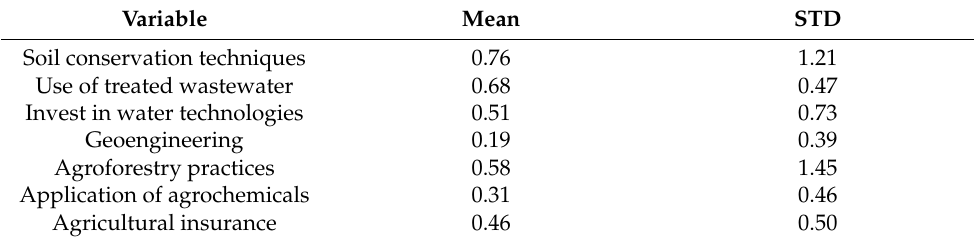
Figure 2. Main adaptation measures promoted by farmers. Note: Options at 95% CI. Table 7. Descriptive statistics of climate change adaptation measures.